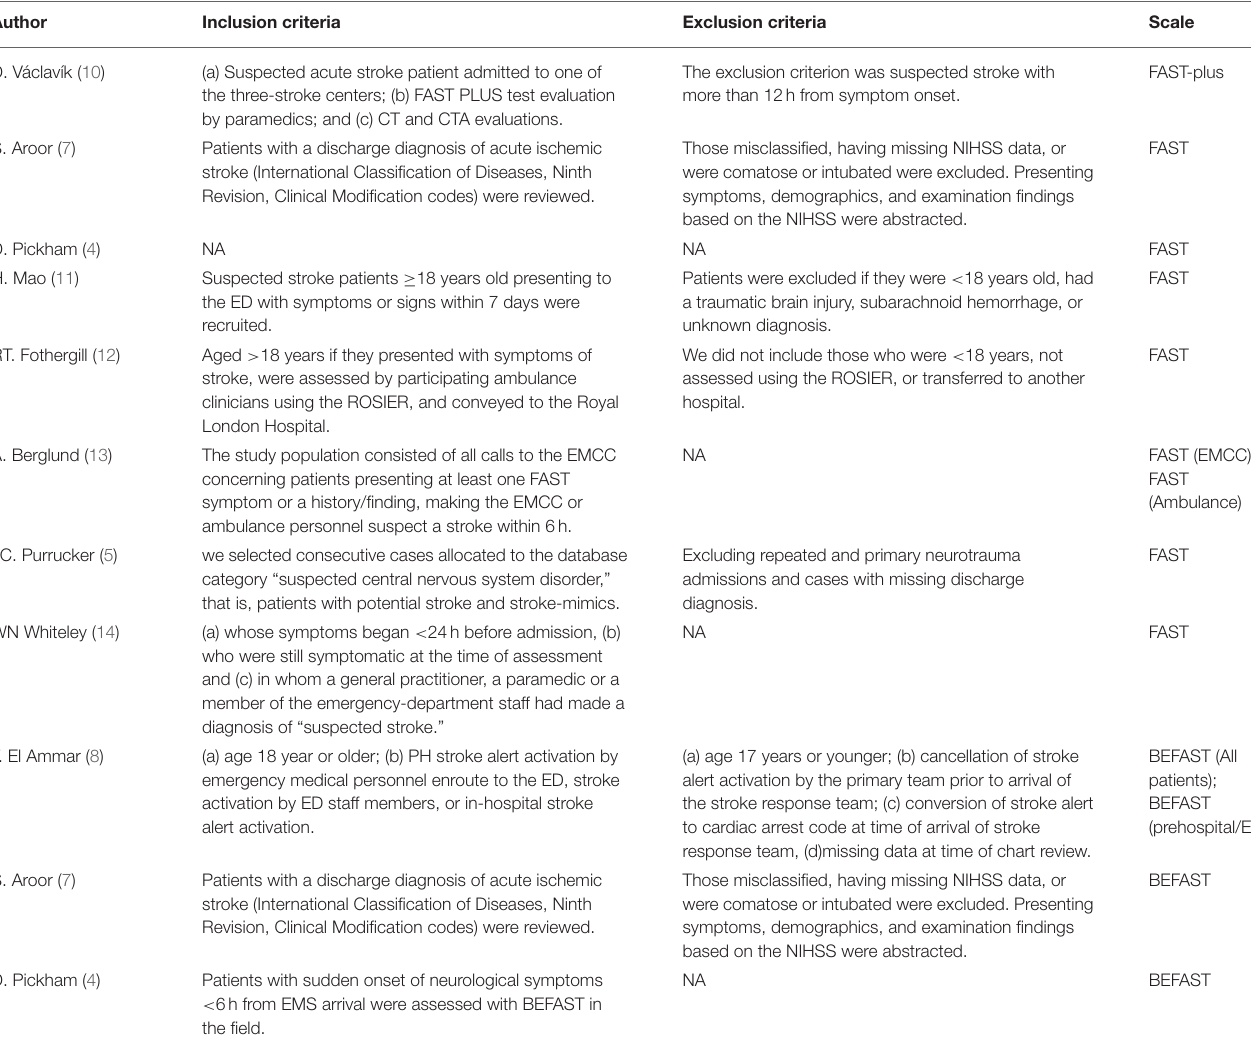
TABLE 2 | Inclusion and exclusion